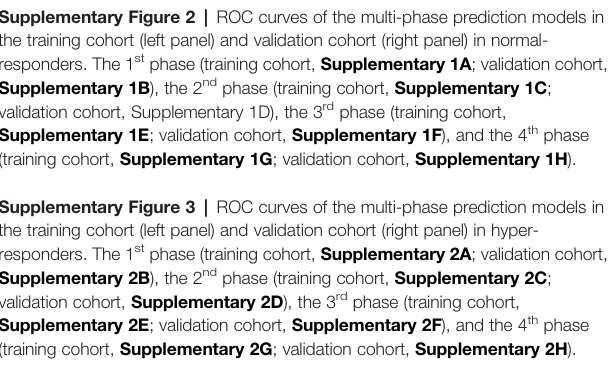
Supplementary Figure 1 | Nomograms of the multi-phase prediction models to predict OHSS in the general population. Nomograms of the 1 st phase (2A), the 2 nd phase (2B), the 3 rd phase (2C), and the 4 th phase (2D). Abbreviations: OHSS, ovarian hyper-stimulation syndrome; COS, controlled ovarian stimulation; AMH, anti-Mullerian hormone; BMI, body mass index; PCOS, polycystic ovarian syndrome; Gn, gonadotropin; E2, estradiol; P progesterone; AFC, antral follicle counting; ET, embryo transfer. Supplementary Figure 2 | ROC curves of the multi-phase prediction models in the training cohort (left panel) and validation cohort (right panel) in normal- responders. The 1 st phase (training cohort, Supplementary 1A ; validation cohort, Supplementary 1B ), the 2 nd phase (training cohort, Supplementary 1C ; validation cohort, Supplementary 1D), the 3 rd phase (training cohort, Supplementary 1E ; validation cohort, Supplementary 1F ), and the 4 th phase (training cohort, Supplementary 1G ; validation cohort, Supplementary 1H ). Supplementary Figure 3 | ROC curves of the multi-phase prediction models in the training cohort (left panel) and validation cohort (right panel) in hyper- responders. The 1 st phase (training cohort, Supplementary 2A ; validation cohort, Supplementary 2B ), the 2 nd phase (training cohort, Supplementary 2C ; validation cohort, Supplementary 2D ), the 3 rd phase (training cohort, Supplementary 2E ; validation cohort, Supplementary 2F ), and the 4 th phase (training cohort, Supplementary 2G ; validation cohort, Supplementary 2H